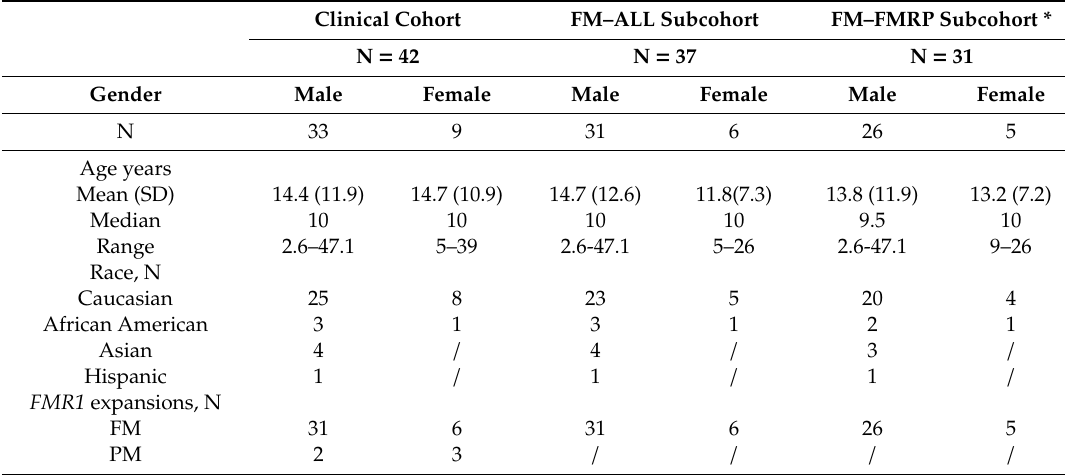
Table 1. Characteristics of the clinical cohort.